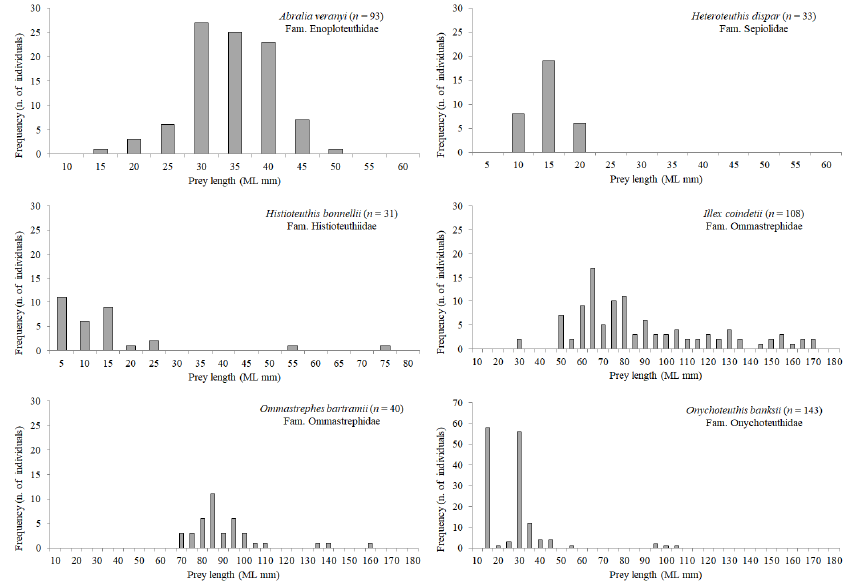
Figure 6. Length frequency distribution of the most abundant mesopelagic cephalopod prey found in BFT stomachs in the Strait of Messina. Given the variability among species in size range and number of individuals, graphs have different scaling on x ‐ and y ‐ axes.